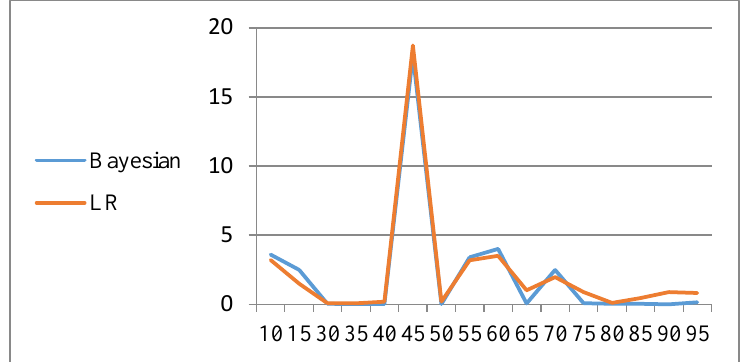
Fig. 1. Comparison of Bayesian and LR results.